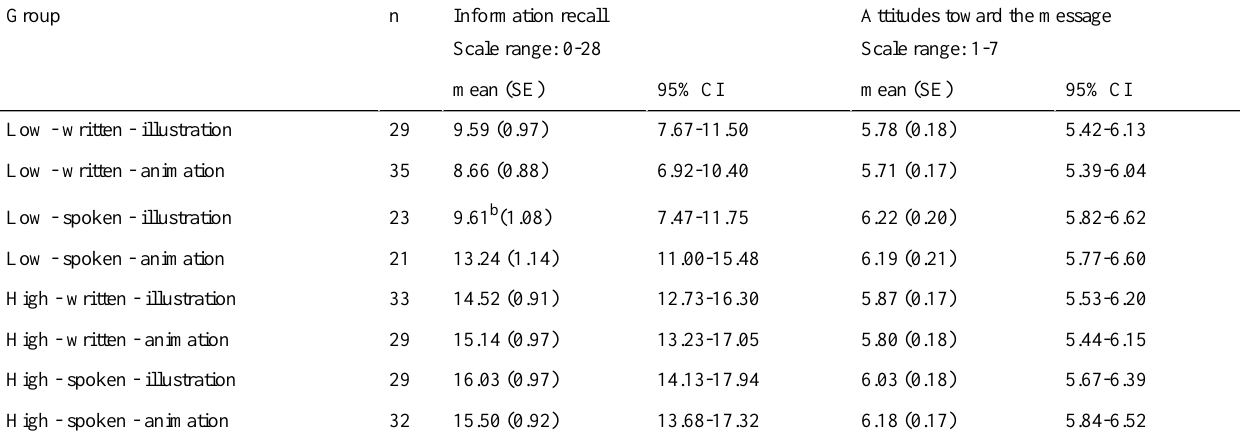
Table 3. Interaction effects of text modality and visual animation in people with low or high health literacy. a